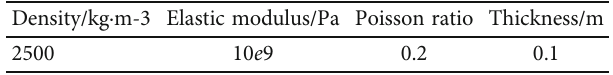
Table 7: Surface element